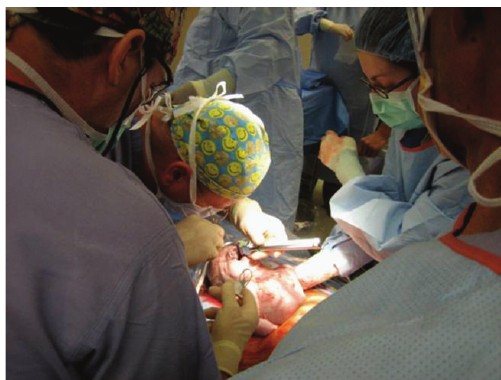
Figure 1: Ultrasound image at 26-week gestation demonstrating oropharyngeal cyst (black arrow). Figure 2: Intraoperative image of EXIT procedure. The fetus is delivered to level of upper abdomen with the fetal head and neck stabilized by the obstetrician. The pediatric anesthesiologist performs direct